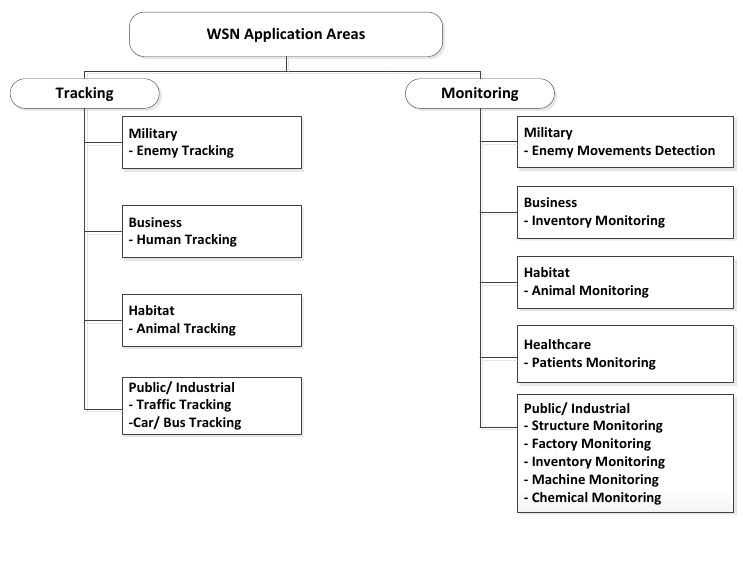
Figure 2. Some of WSN application areas. Adapted from [3].